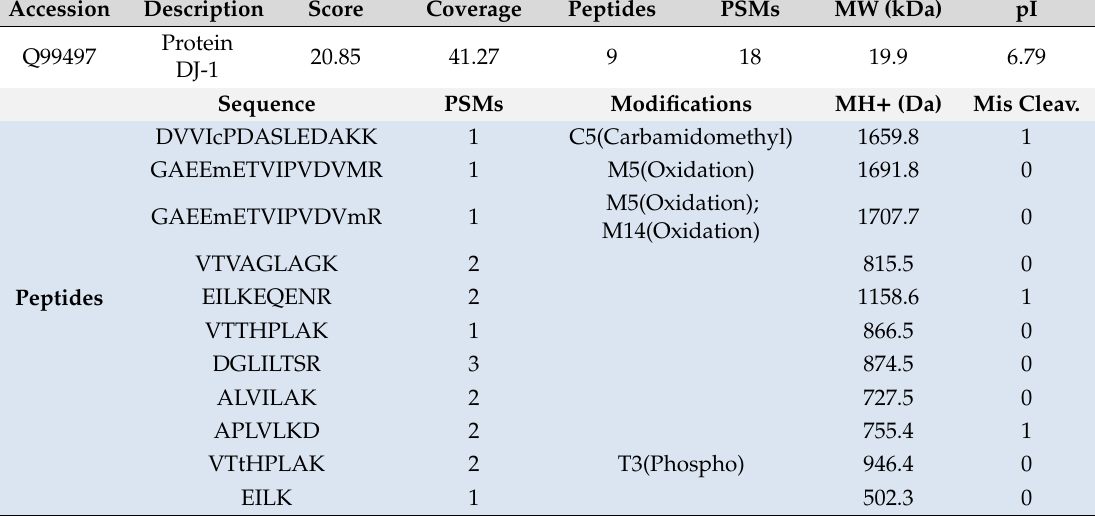
Table 1. DJ-1 LC-MS / MS Identification. Protein spots from gel shown in Figure 2B, were excised, trypsin digested, and identified by LC-MS / MS analysis. In the table below, DJ-1 identification is reported. The phosphorylated peptide in threonine is underlined in red. In the table are: Accession number, Univocal code identifying the protein on the Uniprot database (https: // www.uniprot.org); Description of identified protein; Score of identification; Coverage, percentage of amino acid identified by MS / MS analysis; Peptides, number of peptides uniquely identifying the protein; PSMs, total number of identified peptide spectra matched for the protein; AAs, MW, molecular weight of identified protein; pI, theoretical isoelectric point of identified protein; Sequence of identified peptide; PSMs, total number of identified peptide spectra matched for the peptides; Modification, position of modified residue and type of modification; MH + Molecular weight of positive ion; and Miss cleavages, number of allowed missed cleavage. White row is referred to protein MS data. Blue rows are referred to peptide MS